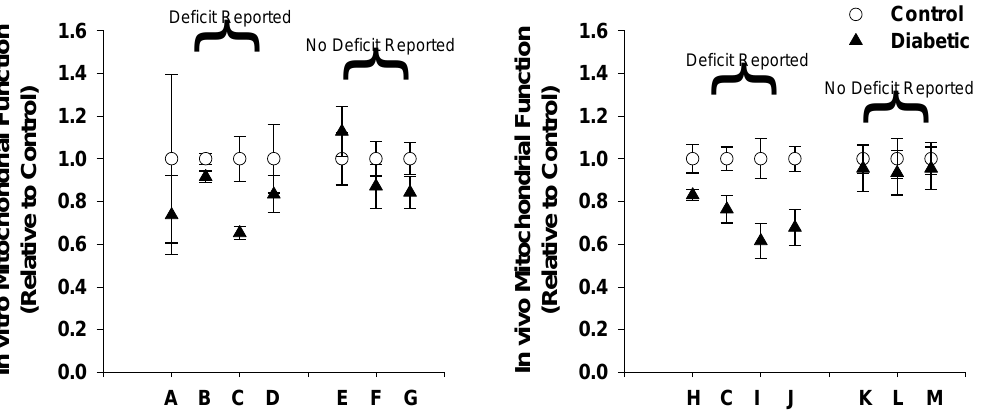
Figure 4. Summary of human mitochondrial (dys)function in diabetes. Data of reported mitochondrial (dys)function was compiled from the literature and presented relative to respective control subjects. Control (white circles) is always equal to 1 and diabetics (black triangles) presented as a fraction of that determined from the reported measures of function. This was determined for (A) in vitro and (B) in vivo studies where both deficits and no deficits in mitochondrial function have been reported. A) Kelley 2002; B) Mogensen 2007; C) Phielix 2008; D) Ritov 2005; E) Abdul-Ghani